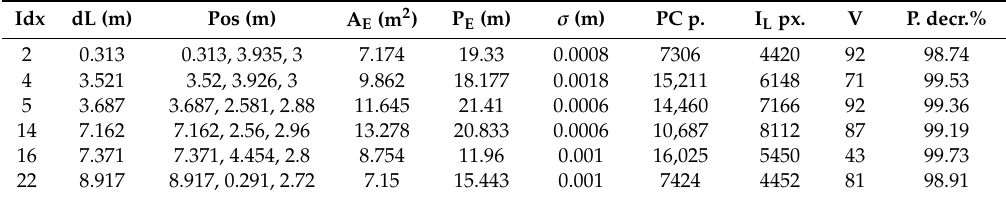
Table 2. Detected planes with the physical description in the